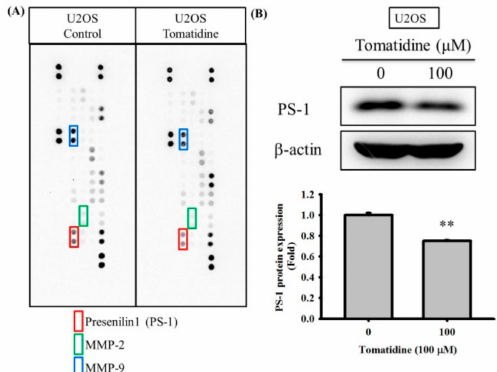
Figure 3. Presenilin 1 expression of tomatidine-treated in osteosarcoma U2OS cells. ( A ) The protease array after treatment with 100 µ M of tomatidine for 24 h in U2OS cells were employed as described in the Materials and Methods section. ( B ) Western blot analysis after various concentrations (0 and 100 µ M) of tomatidine treatment for 24 h in U2OS cells were measured as described in the Materials and Methods section and the e ff ects were illustrated after quantitative analysis. The results are shown as mean ± S.D. n = 3. Student’s t-test was used. ( B ) p = 0.001. **Significantly di ff erent: p < 0.01, when compared with the control group (0 µ M).